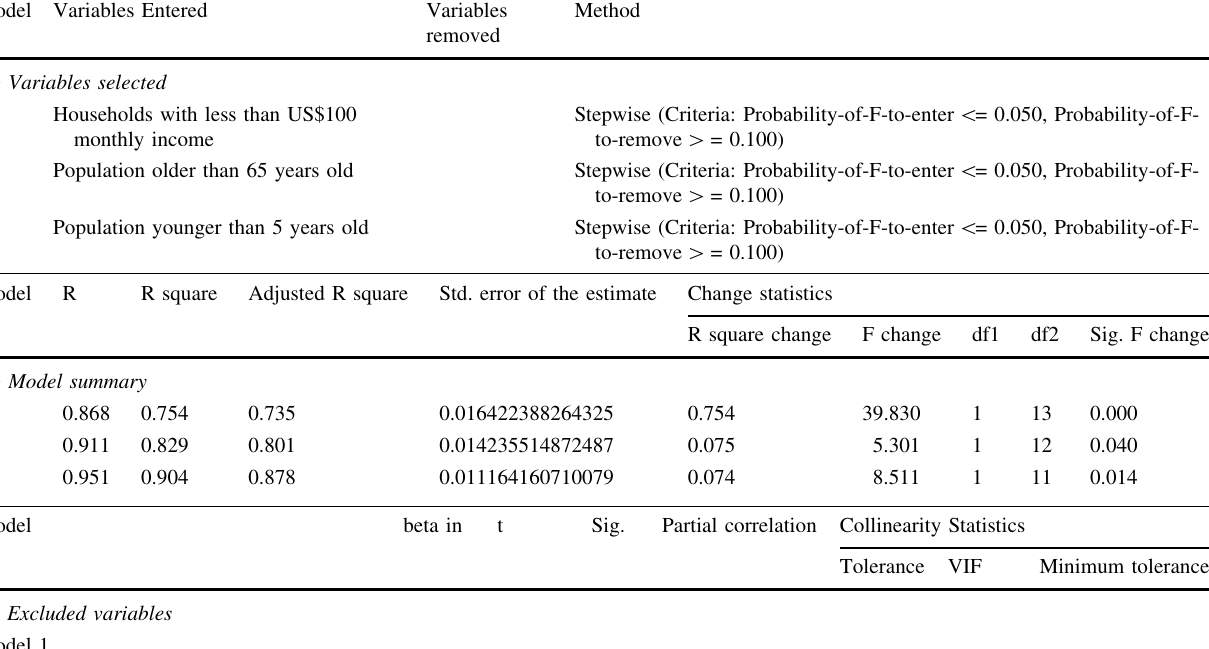
Table 4 Results from the stepwise regression analysis between average child mortality from 2012 to 2016 and selected socioeconomic indicators in La Guajira,